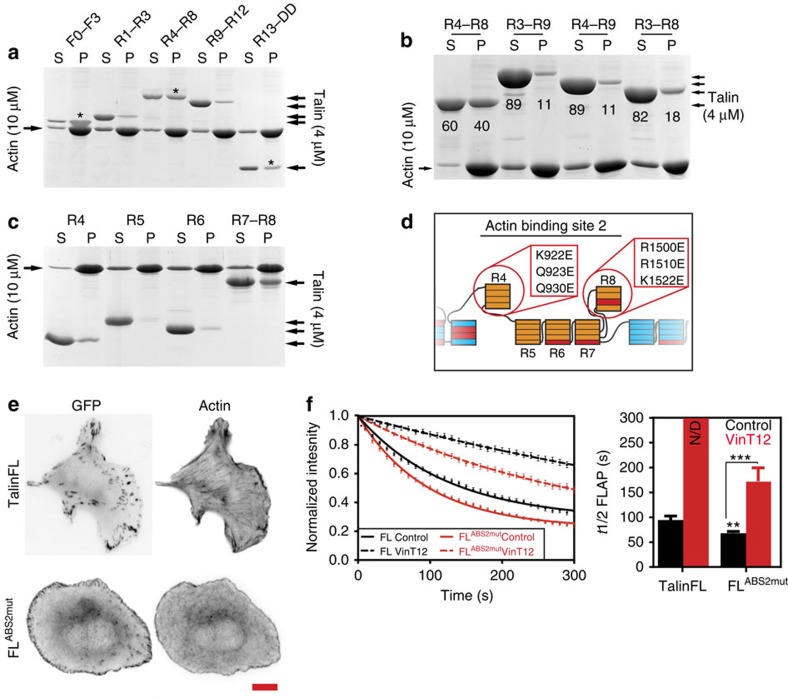
ABS2 is a key regulator of talin.(a,b) Recombinant talin polypeptides were incubated with F-actin, the actin pelleted, and supernatants (S) and pellets (P) analysed by SDS–PAGE. (a) Talin FERM domain F0-F3 (ABS1) followed by talin rod domains R1-R3, R4-R8 (ABS2), R9-R12 and R13-DD (ABS3). Asterisks show the domains containing the known ABSs. (b) Actin co-sedimentation assays show that actin binding to ABS2 is reduced when either domain R3 or R9 is present; numbers show percent band density (c) Actin co-sedimentation studies using the 4 sub-domains that make up ABS2; Note that R4 and R7-R8 bind actin. (d) Scheme outlining point mutations in the talin rod that reduce actin binding to ABS2. (e) Expression of talin ABS2 mutant (FLABS2mut) in TKO cells rescued cell spreading, but resulted in rounder cells with smaller FAs compared with talinFL cells (see also Supplementary Fig. 6a,b; scale bar, 10 μm). (f) FLAP experiments in TKO cells show that the turnover of talinFLABS2mut is increased compared with talinFL (FL control). Note that co-expression with vinT12 reduced the turnover of talinFLABS2mut to a lesser extent than talinFL. The almost linear decay of the talinFL in presence of vinT12 (FL VinT12) prevented appropriate fitting, hence accurate t½ FLAP could not be determined; N/D=not determined (n=28–56 FAs, from three independent experiments, error bars are±s.e.m., ***=P<0.001 (ANOVA)).